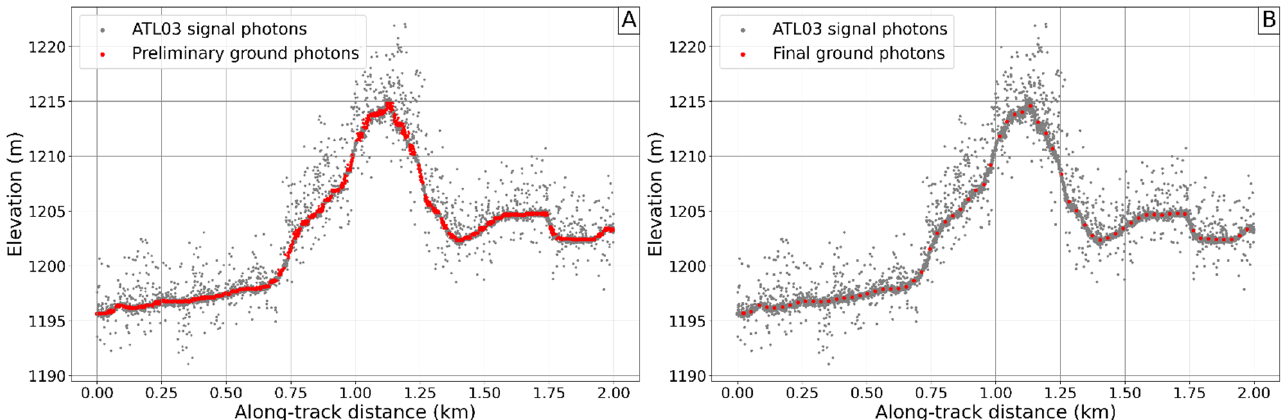
Figure 5. Characteristic example of ground-photon classification with gray dots showing all extracted signal photons from the ATL03 product (strong beam, gt1l, daytime acquisition with ID: ATL03_20190116100224_02890214_004_01). ( A ) Preliminary ground photons in 30 m steps are in red after extracting photons within the 25–75th height percentiles. This corresponds to step 1 and 2 as described in Section 3.6.1. ( B ) Final ground photons are selected based on additional